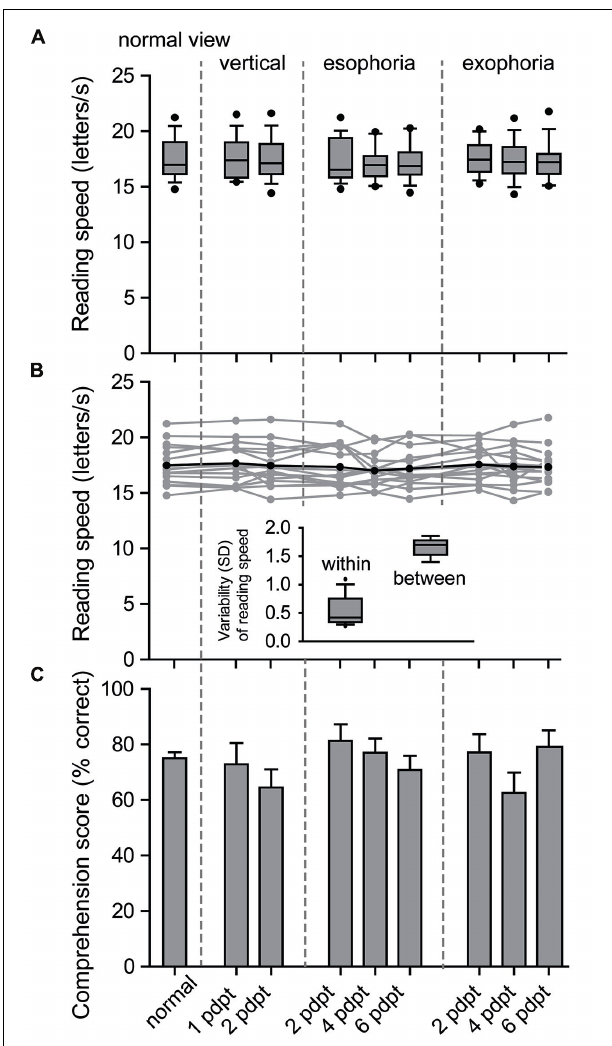
FIGURE 1 | Reading performance with prism induced changes of the vergence tone. Decreased convergence tone, such as is experienced in esophoria, and increased convergence tone, as is experienced in exophoria was induced by placing prisms base medially and base laterally, respectively. Boxplots (A) show reading speed (letters/s) for normal view and each prism condition.The boxes contain the mean and 50% of the data, and the whiskers indicate 10/90% of the data. Mean reading speed of each subject reveals less intrasubject variability than between subject variability (B ; gray = subjects, black = mean of all subjects). Inset figure shows mean variability of mean reading speed within subjects and between subjects. Bar chart showing the mean comprehension score (% correct answers) ± standard error of the mean for normal view and each prism condition (C)